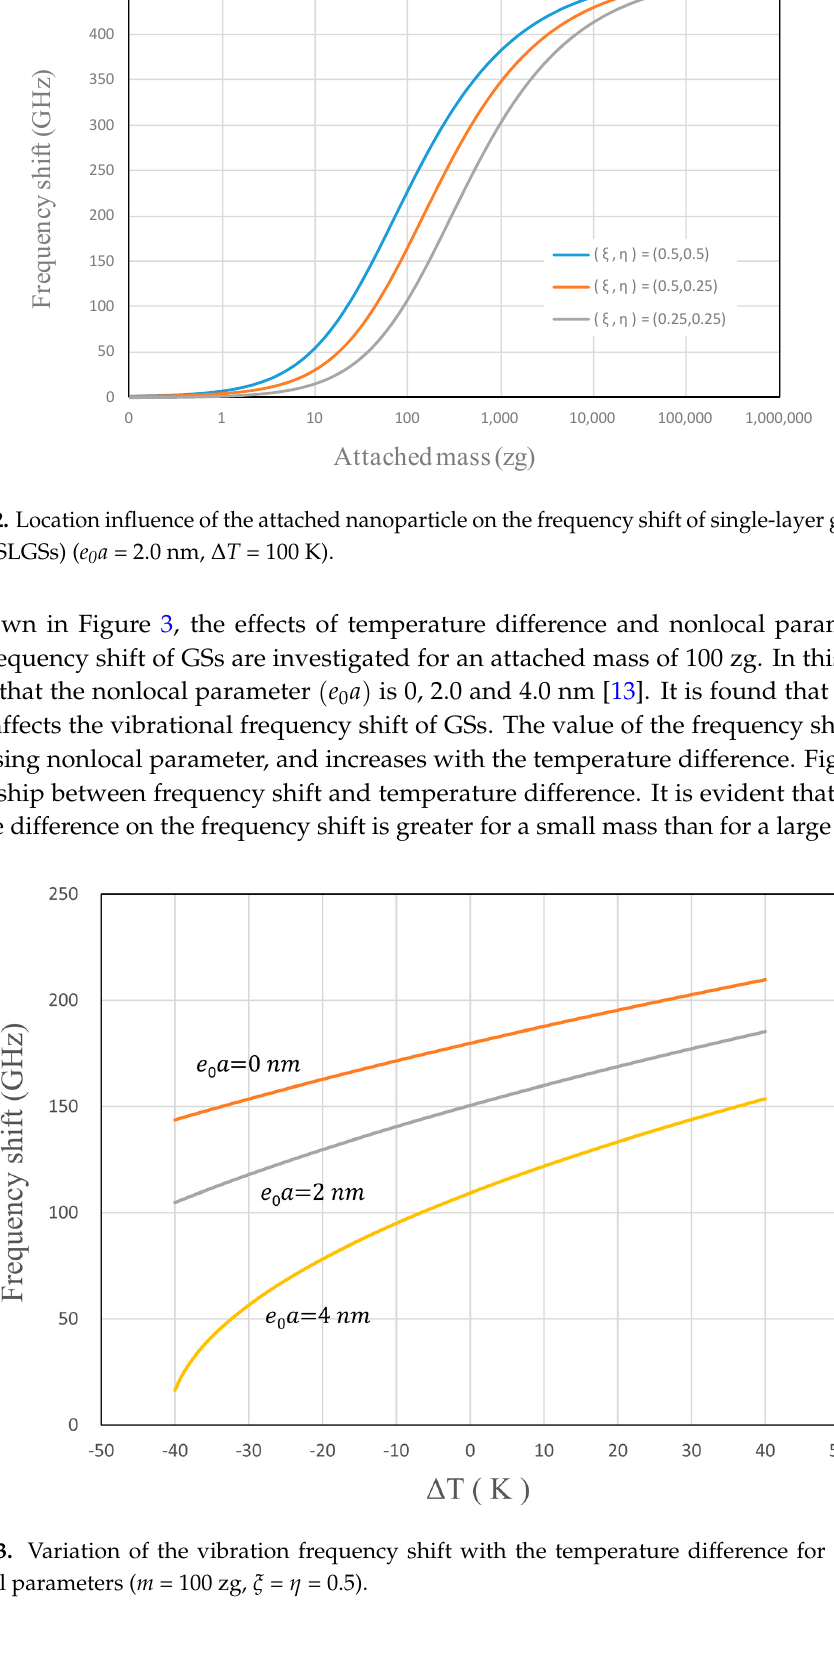
Figure 4. Variation of the vibration frequency shift with the temperature difference for different nanomass sizes ( e 0 a = 2.0 nm, ξ = η = 0.5). Figure 5 shows a comparison of the frequency shift between SLGSs and DLGSs with the temperature difference of 100 K. The frequency shift of the GS resonator increases with increasing mass of nanoparticles. The DLGSs used as a nanomechanical resonator can provide higher sensitivity than the SLGSs due to large change in the vibrational frequency shift. It can be found that the frequency shift versus the attached mass show a nearly logarithmic linear relationship within a certain range. According to this simulation, the relationship between the frequency shift 